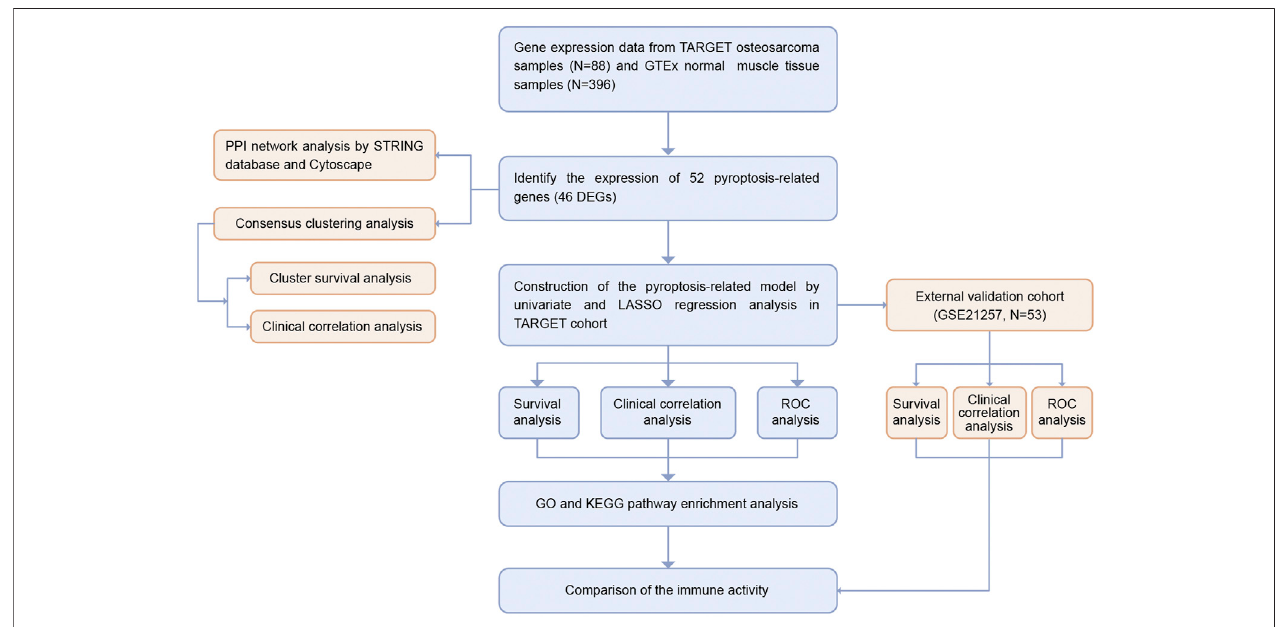
FIGURE 1 | Flow chart of the